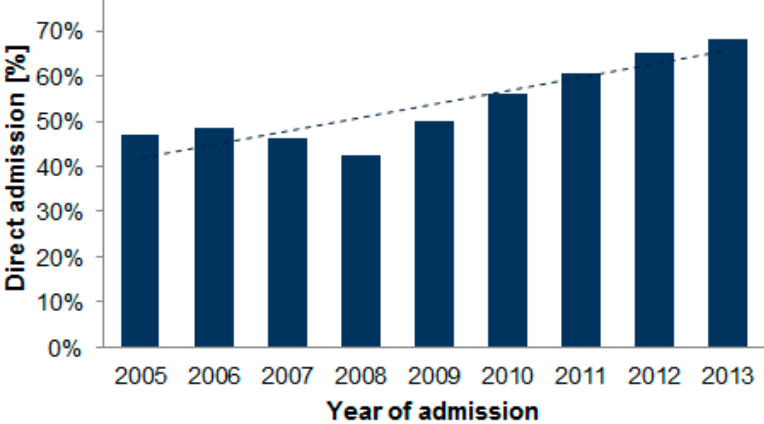
Figure 2. Rate of direct admissions to PCI centers in each year of study period. The fitted linear regression line indicates the trend ( p < 0.001).